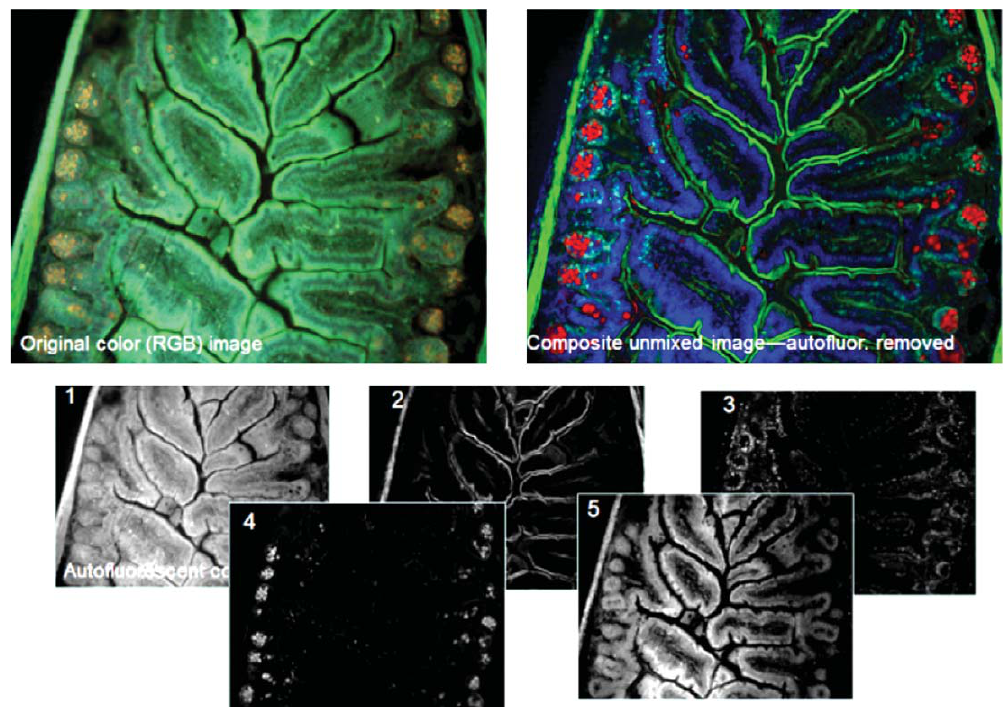
Fig. 8. Mouse bowel spectrally imaged. Four Alexa dyes and autofluorescence are unmixed; an AF-free composite is shown.